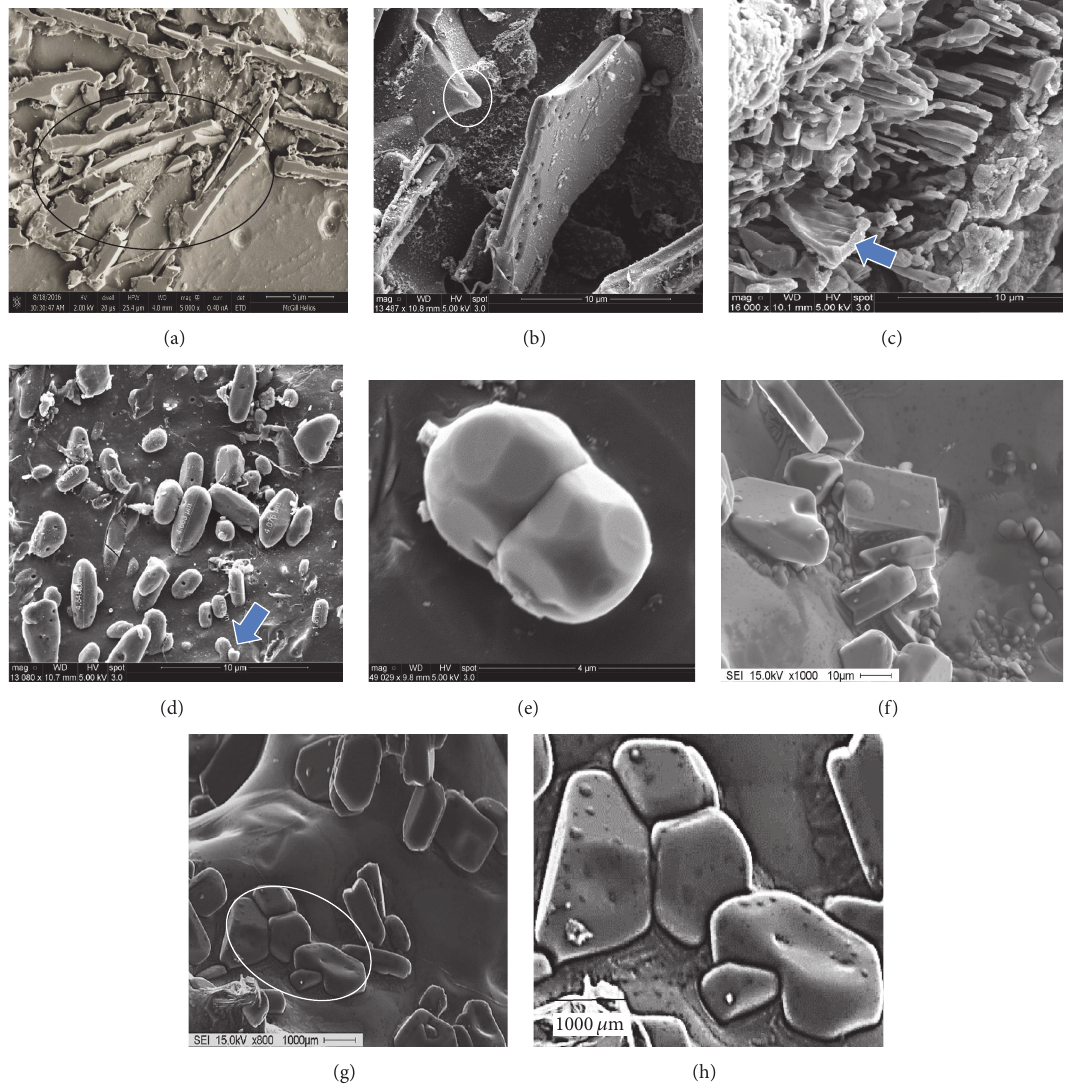
Figure 6: Variation in the morphology of eutectic Si particles in A413 alloy as a function of alloy/heat-treated condition: ((a) and (b)) as cast, unmodified, (c) as cast, modified with 240 ppm Sr, ((d) and (e)) modified and SHT for 8h at 505 ∘ C, (f) modified and SHT for 8 h at 540 ∘ C, and (g) modified and SHT for 100h at 540 ∘ C. Note the polyhedral/polygonal morphology of the Si particles in (e–g); (h) an enlargement of the circled area in (g) showing the growth of Si particles by coalescence of the adjacent Si particles. SHT: solution heat